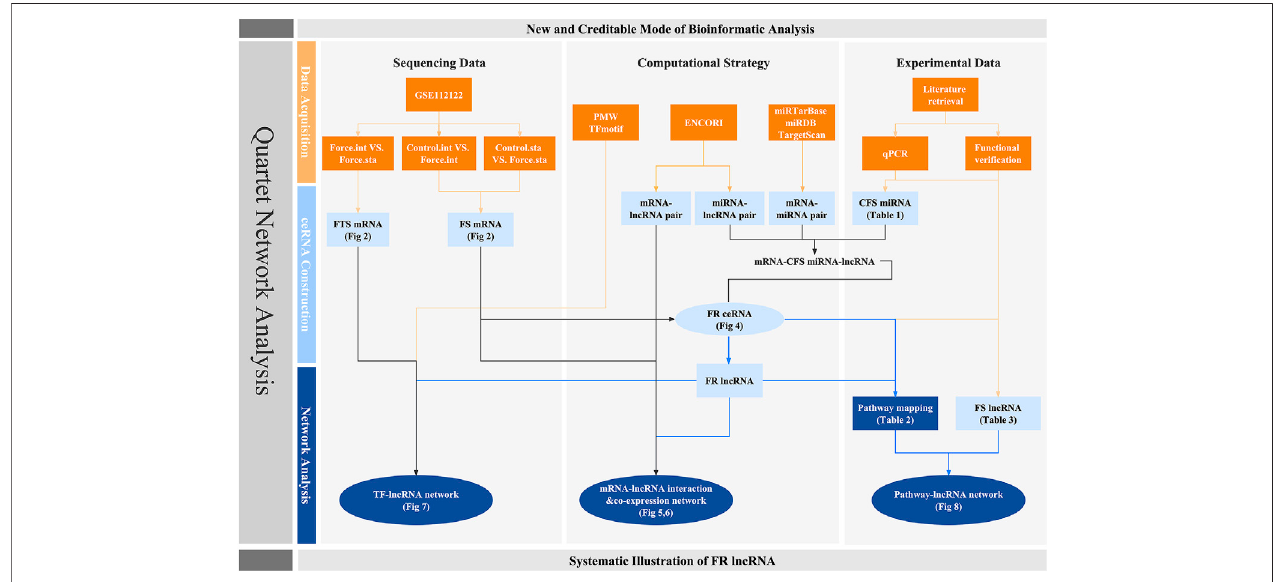
FIGURE1| Work fl owofthisresearch.Orangesquaresstandforthedatabaseandevidencesonwhichourresearchisbased.Lightanddarkbluecolorsrepresent the crucial factors and networks predicted though bioinformatic strategy, respectively. Circles are used to highlight the quartet network of lncRNAs.